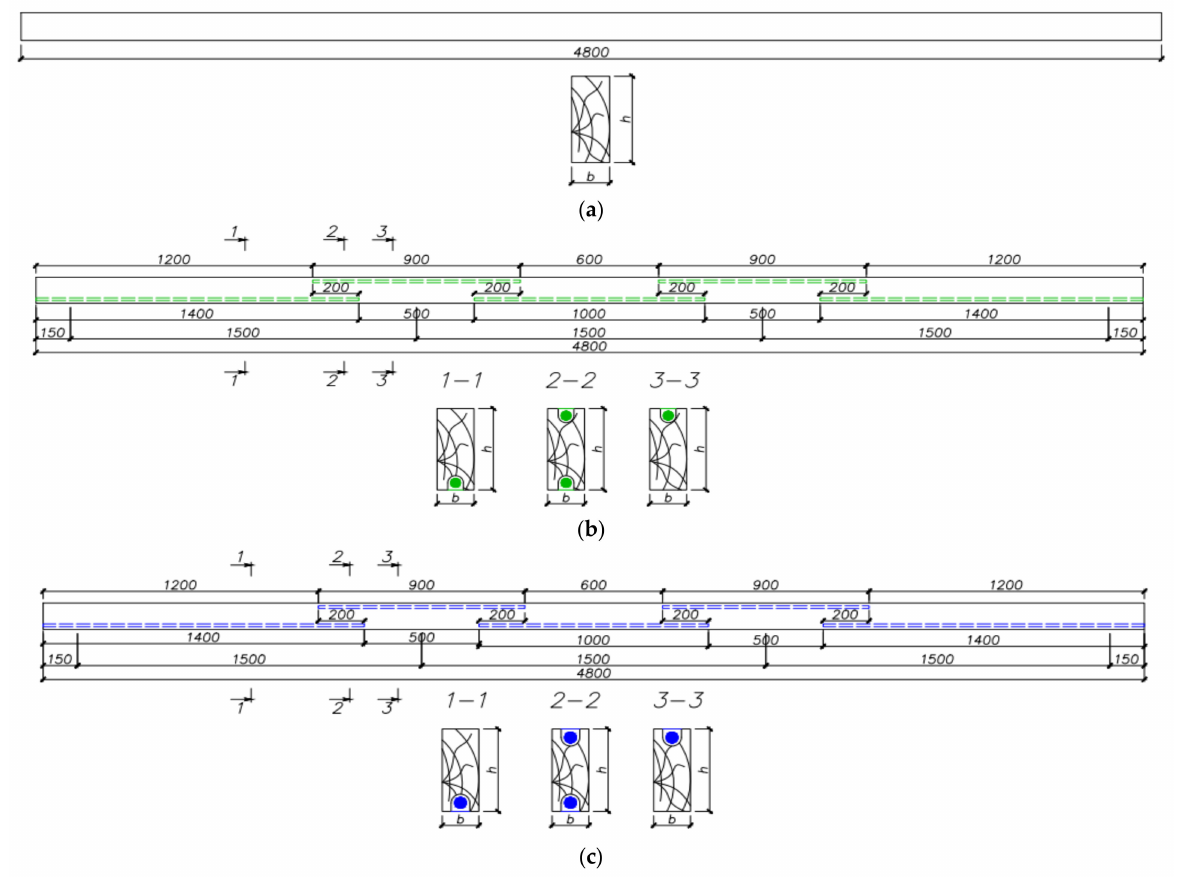
Figure 1. Variants of the investigated multi-span reinforced beam structures: ( a ) series 1—solid wood beam; ( b ) series 2—composite beam, reinforcement coefficient 0.016; ( c ) series 3—composite beam, reinforcement coefficient 0.025. Values are expressed in